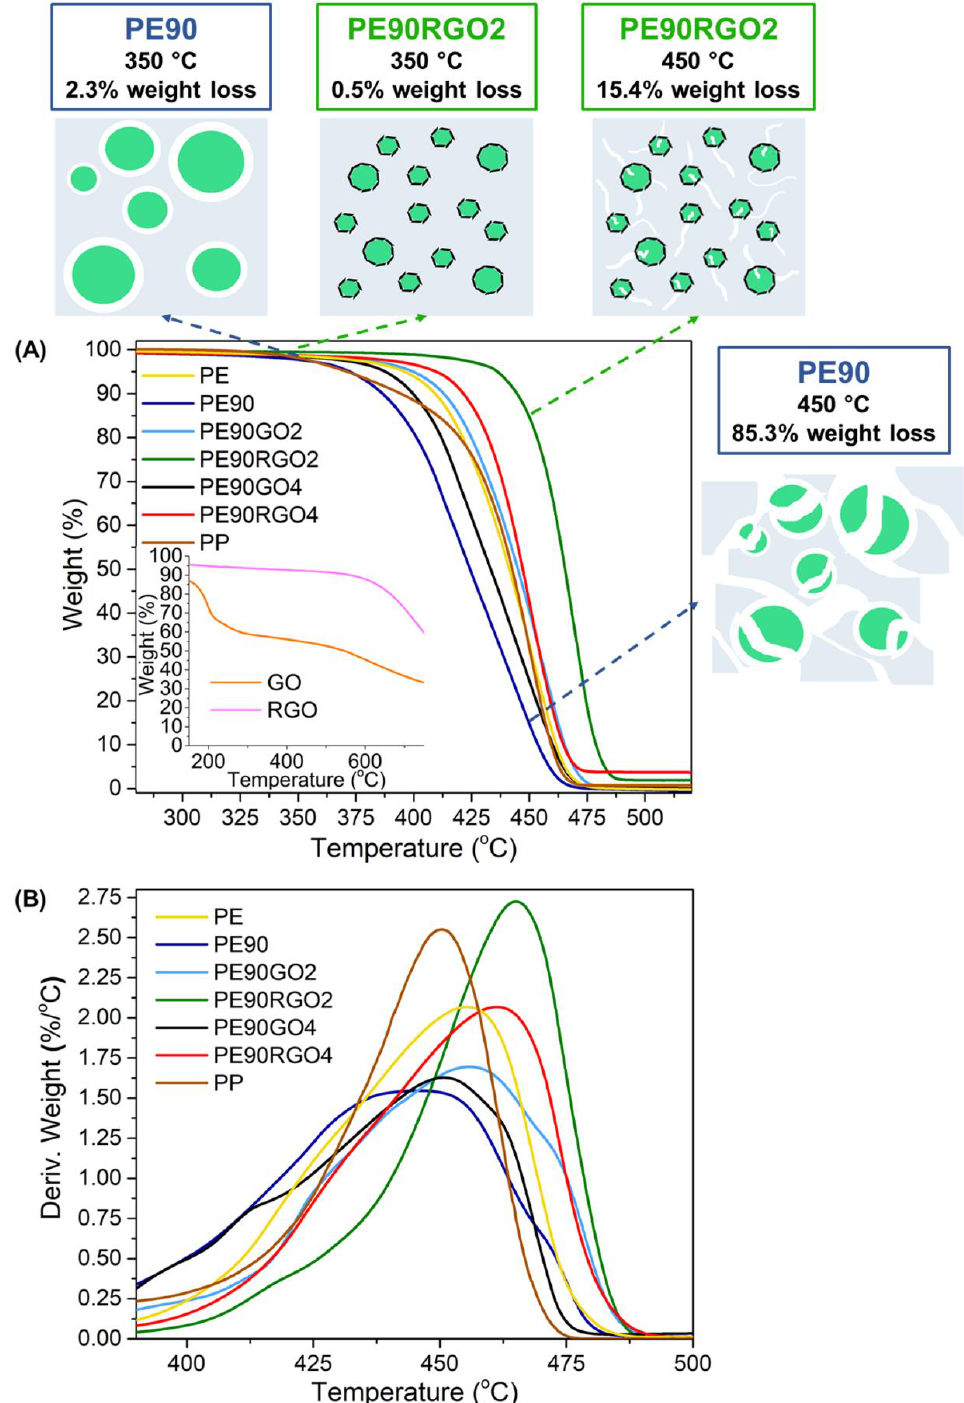
Figure 4. Weight over temperature ( A ) and derivative of weight over temperature ( B ) for unfilled and filled binary systems. (The insert graph of Figure 4A depicts weight over temperature for pure GO and RGO).